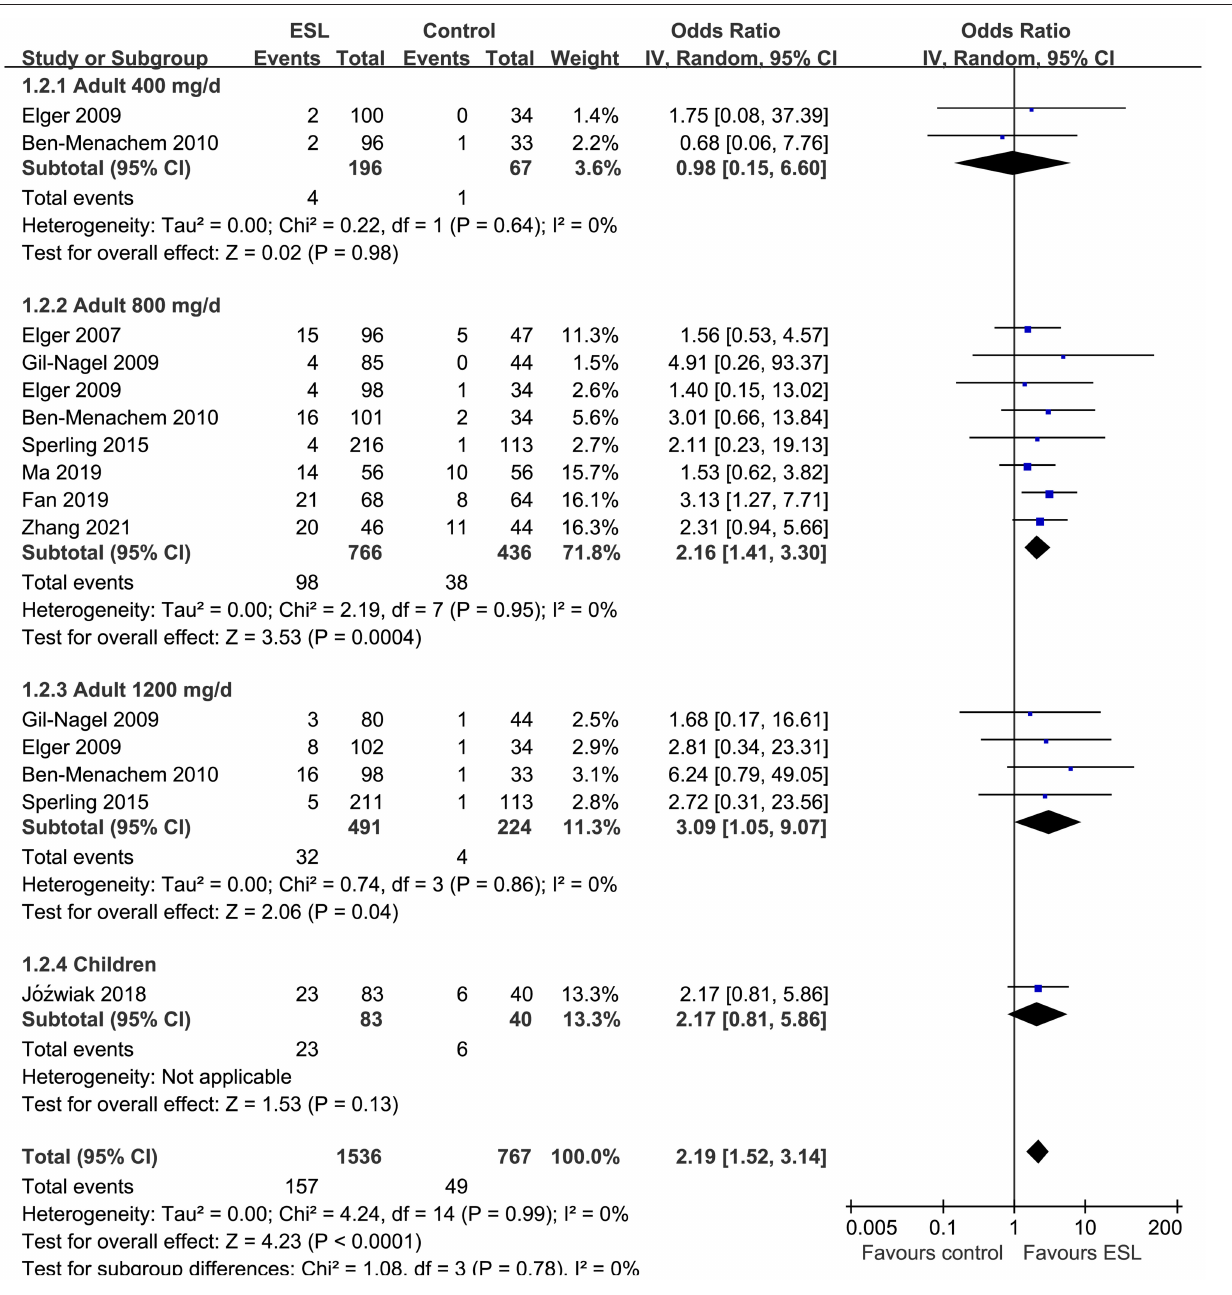
Efficacy and Tolerability of Adjunctive ESL in Children With FOE For children, ESL did not significantly improve the response rate (OR 1.76, 95% CI 0.72–4.28, p = 0.22, I 2 = 68%; Figure 2 ), the effective rate (OR 2.17, 95% CI 0.81–5.86, p = 0.13; Figure 3 ), and the incidence of overall (OR: 1.34, p = 0.57; Figure 4 ) or severe AE (OR: 1.40, p = 0.41; Figure 5